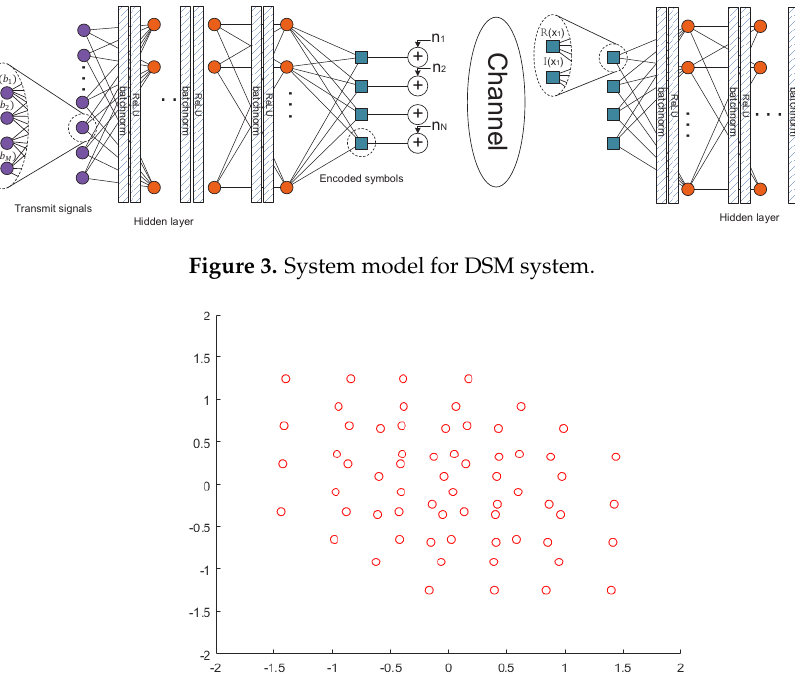
Figure 4. SCMA constellation points.